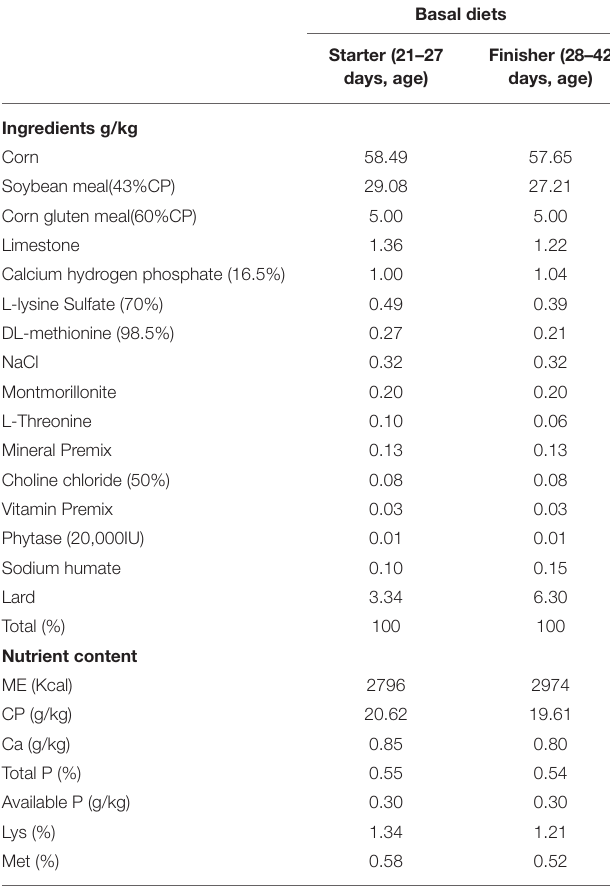
TABLE 1 | Composition and nutrient content of experimental